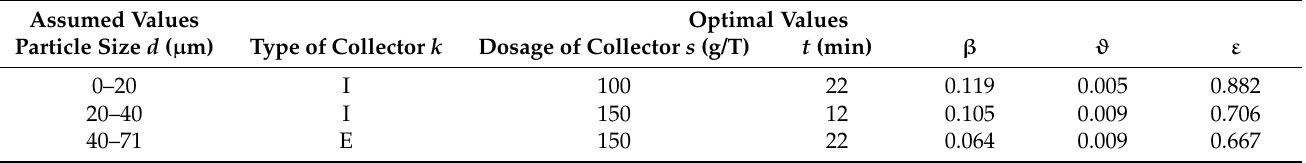
Table 8. Optimal values obtained by the assumed particle size